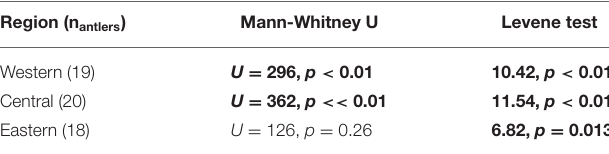
TABLE 2 | Mann-Whitney U and Levene tests between female antler 87 Sr/ 86 Sr and bioavailable 87 Sr/ 86 Sr at collection sites. Region (n antlers ) Mann-Whitney U Levene test Western (19) U = 296, p < 0.01 10.42, p < 0.01 Central (20) U = 362, p << 0.01 11.54, p < 0.01 Eastern (18) U 126, p 0.26 6.82, p = 0.013 = = For each Coastal Plain region, sample size corresponds to the number of female antlers evaluated, which equals the number of estimated bioavailable 87 Sr/ 86 Sr values from the isoscape (Bataille et al., 2020). Significant comparisons are in